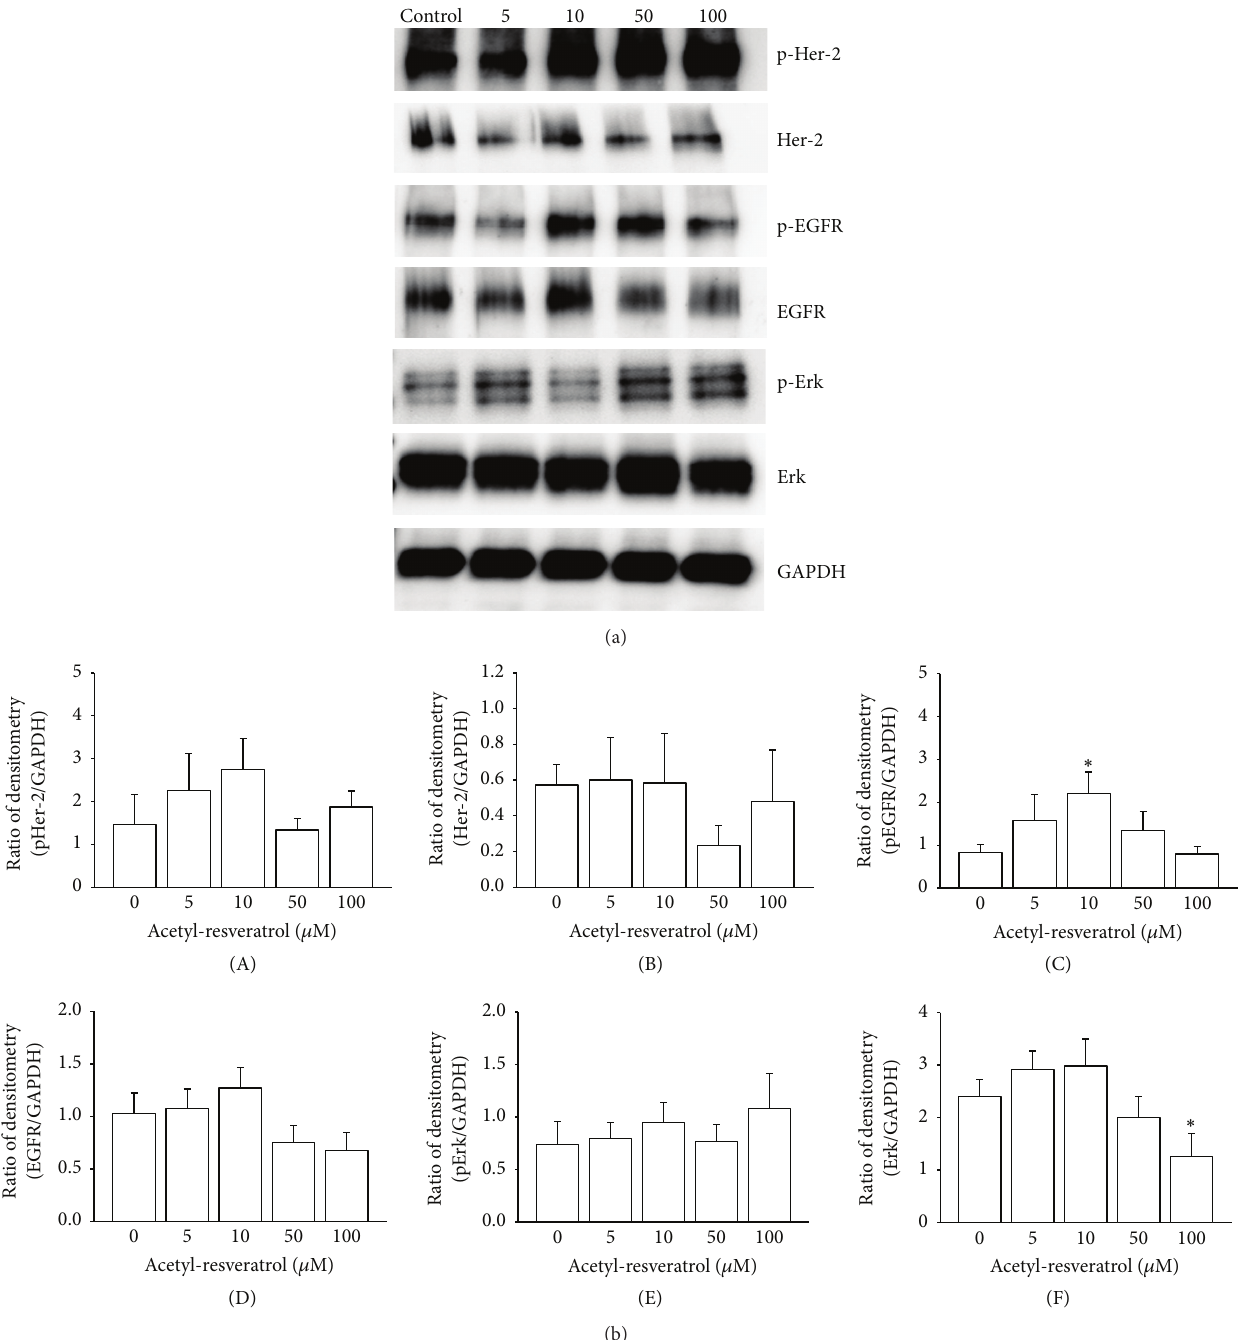
Figure 5: In SKOV-3 cell aggregates, acetyl-resveratrol did not alter the expression of Her-2, but it increased the phosphorylation of EGFR at 10 𝜇 M (C). The total expression of Erk was significantly reduced (F). ∗ refers to statistically significant as 𝑝 value less than 0.05 compared to the